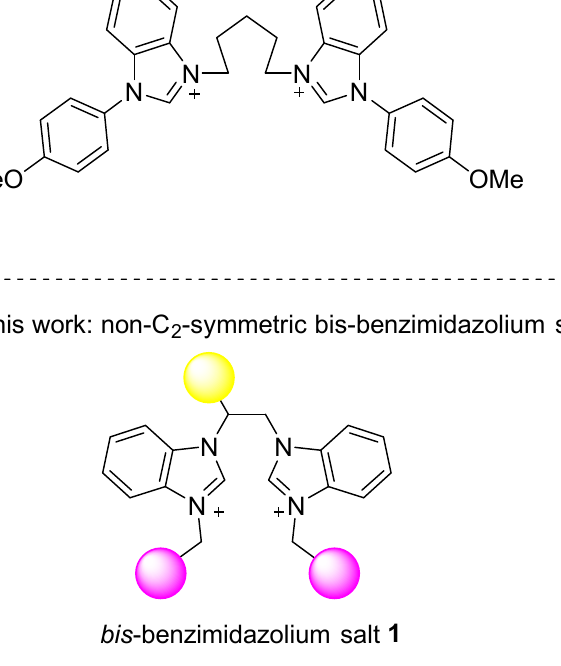
Figure 1. Structures of new non-C 2 -symmetric bis -benzimidazolium salt 1 .